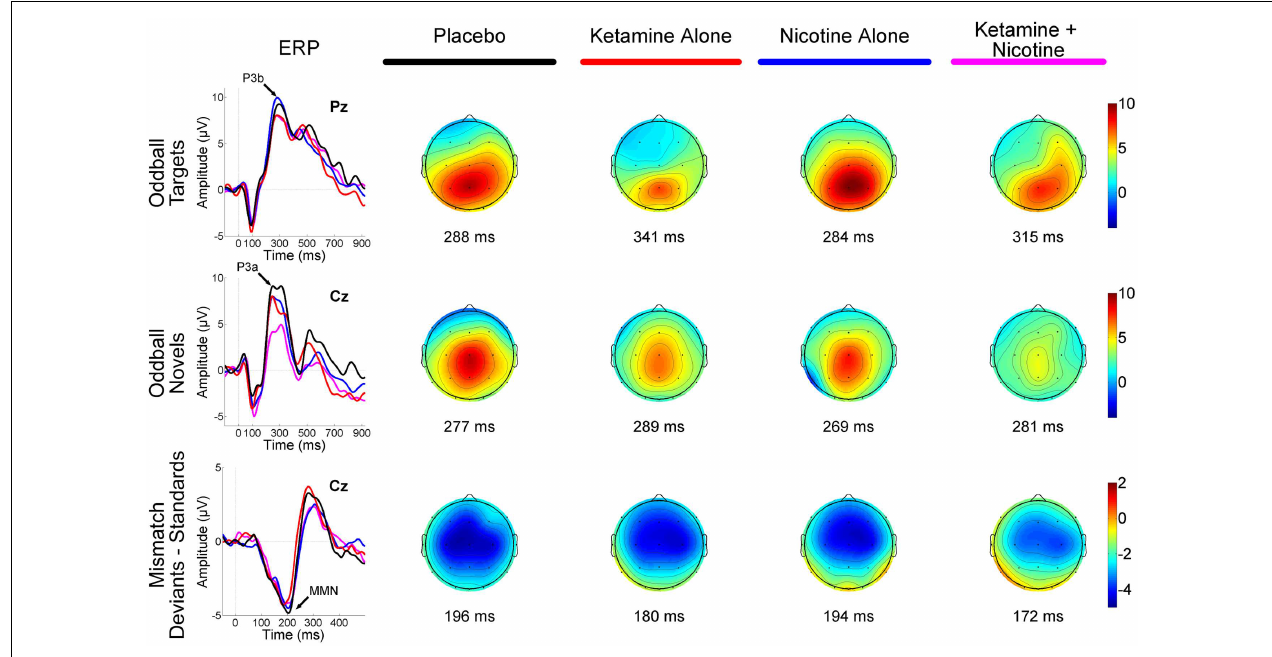
deviant elicited a MMN, with each peak denoted by an arrow on the ERP waveforms. Amplitude in microvolts is on the y -axis, and latency in milliseconds is on the x -axis. Stimulus onset is at 0ms. Negativity is plotted down. Scalp topography maps are shown for each test day for each stimulus, at the peak latency for P3b (top), P3a (middle), and MMN (bottom). Hot colors indicate positive voltage and cool colors, negative